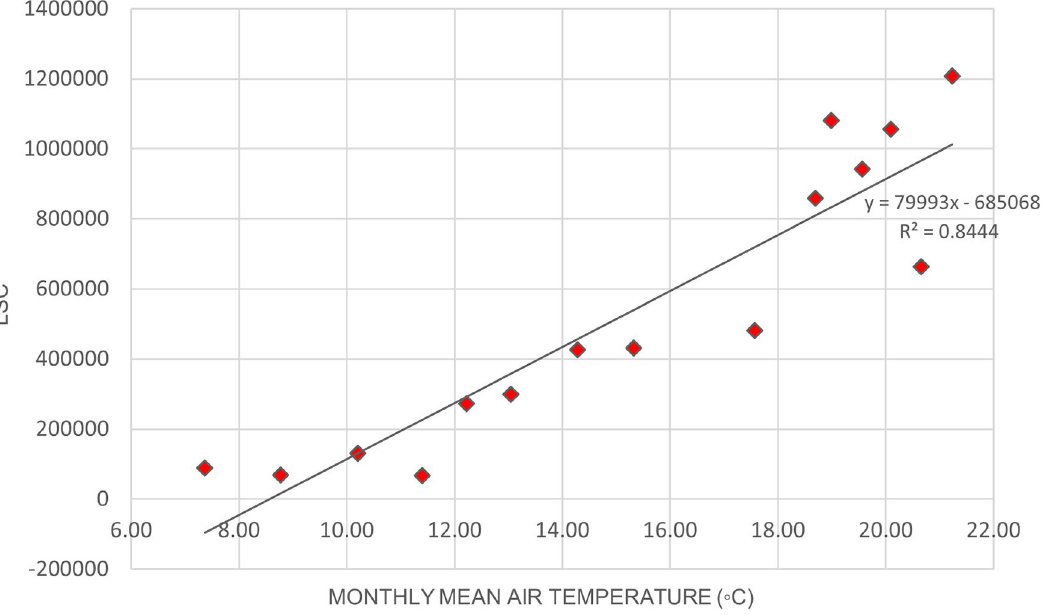
Figure 2. LSC vs air temperature over Europe during March to July 2020.